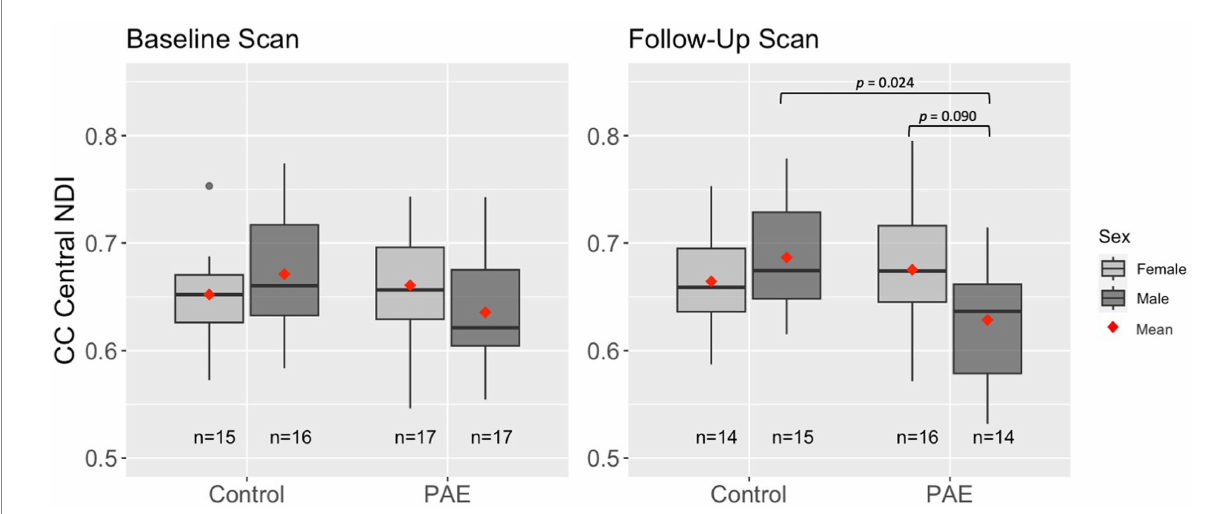
FIGURE 2 Differences in mean NDI in the central CC at baseline and follow-up scan by group and sex. Results are displayed for linear mixed effects models examining group differences (PAE vs. Control) in age-related trajectories of corpus callosum white matter microstructure. Interactions that were not significant or trend-level were removed from the